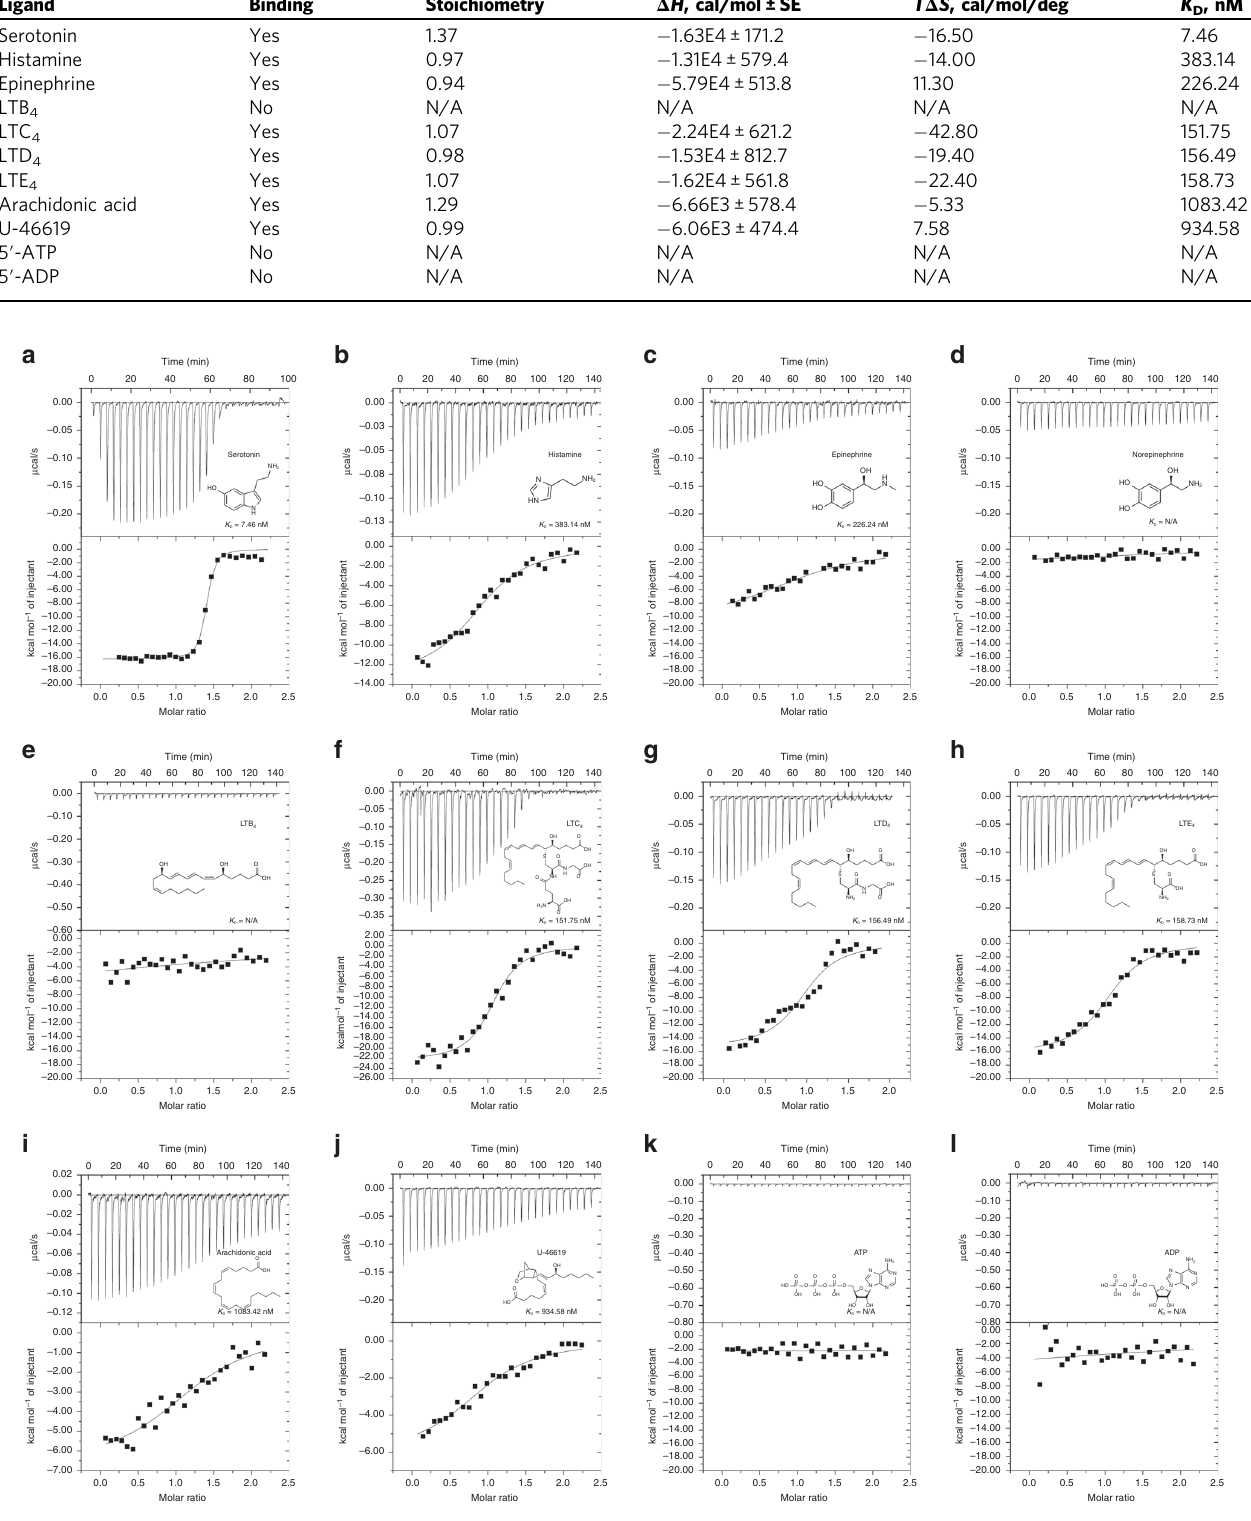
Fig. 3 Binding of biogenic amines and eicosanoids to CxD7L2 by ITC. Binding experiments were performed on a VP-ITC microcalorimeter. The upper curve in each panel shows the measured heat for each injection, while the lower graph shows the enthalpies for each injection and the fi t to a single-site binding model for calculation of thermodynamic parameters. Titration curves are representative of two measurements. Panels: serotonin ( a ), histamine ( b ), epinephrine ( c ), norepinephrine ( d ), LTE 4 ( e ), LTC 4 ( f ), LTD 4 ( g ), LTE 4 ( h ), arachidonic acid ( i ), TXA 2 analog U-46619 ( j ), ATP ( k ), and ADP ( l ). The insets show the names and chemical formulas for these